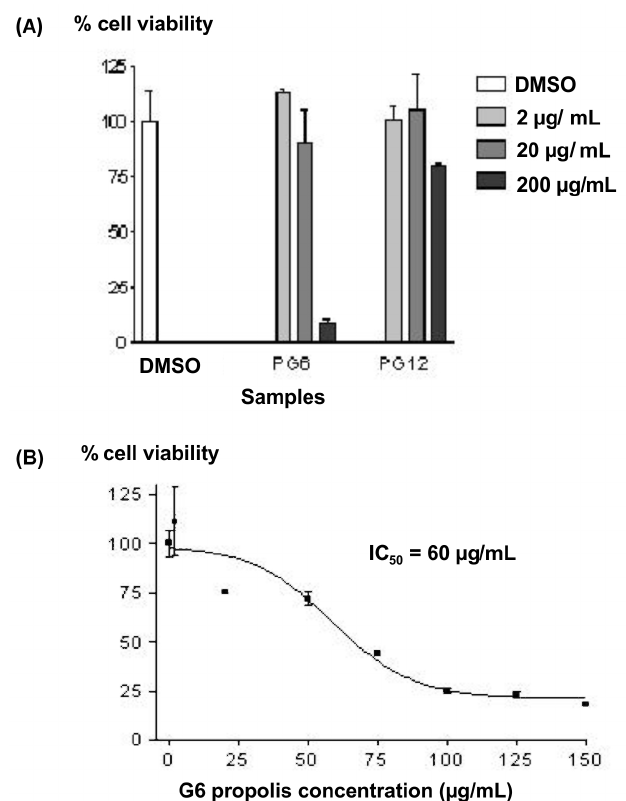
FIGURE 4 - Cytotoxic activity of ethanolic extracts of propolis in different concentrations (A) and cell viability curve after treatment with G6 propolis